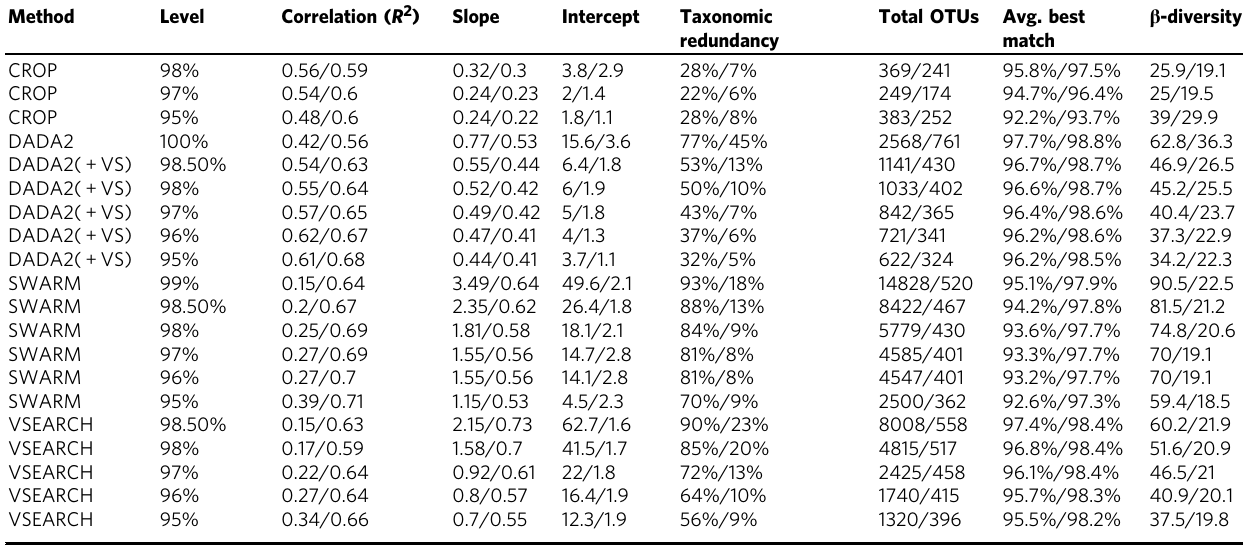
Table 1 Metrics of the OTU tables produced with multiple OTU generation algorithms before and after curation with LULU